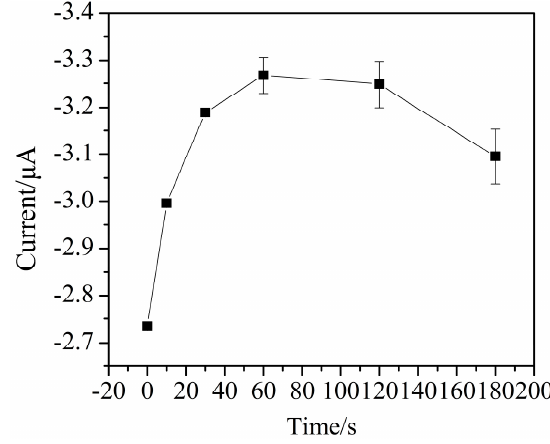
Figure 10. The SEM images of the AuNPs–BDD electrode with different deposition time ( a ) 100 s ( b ) 200 s ( c ) 300 s ( d ) 400 s ( e ) 500 s.